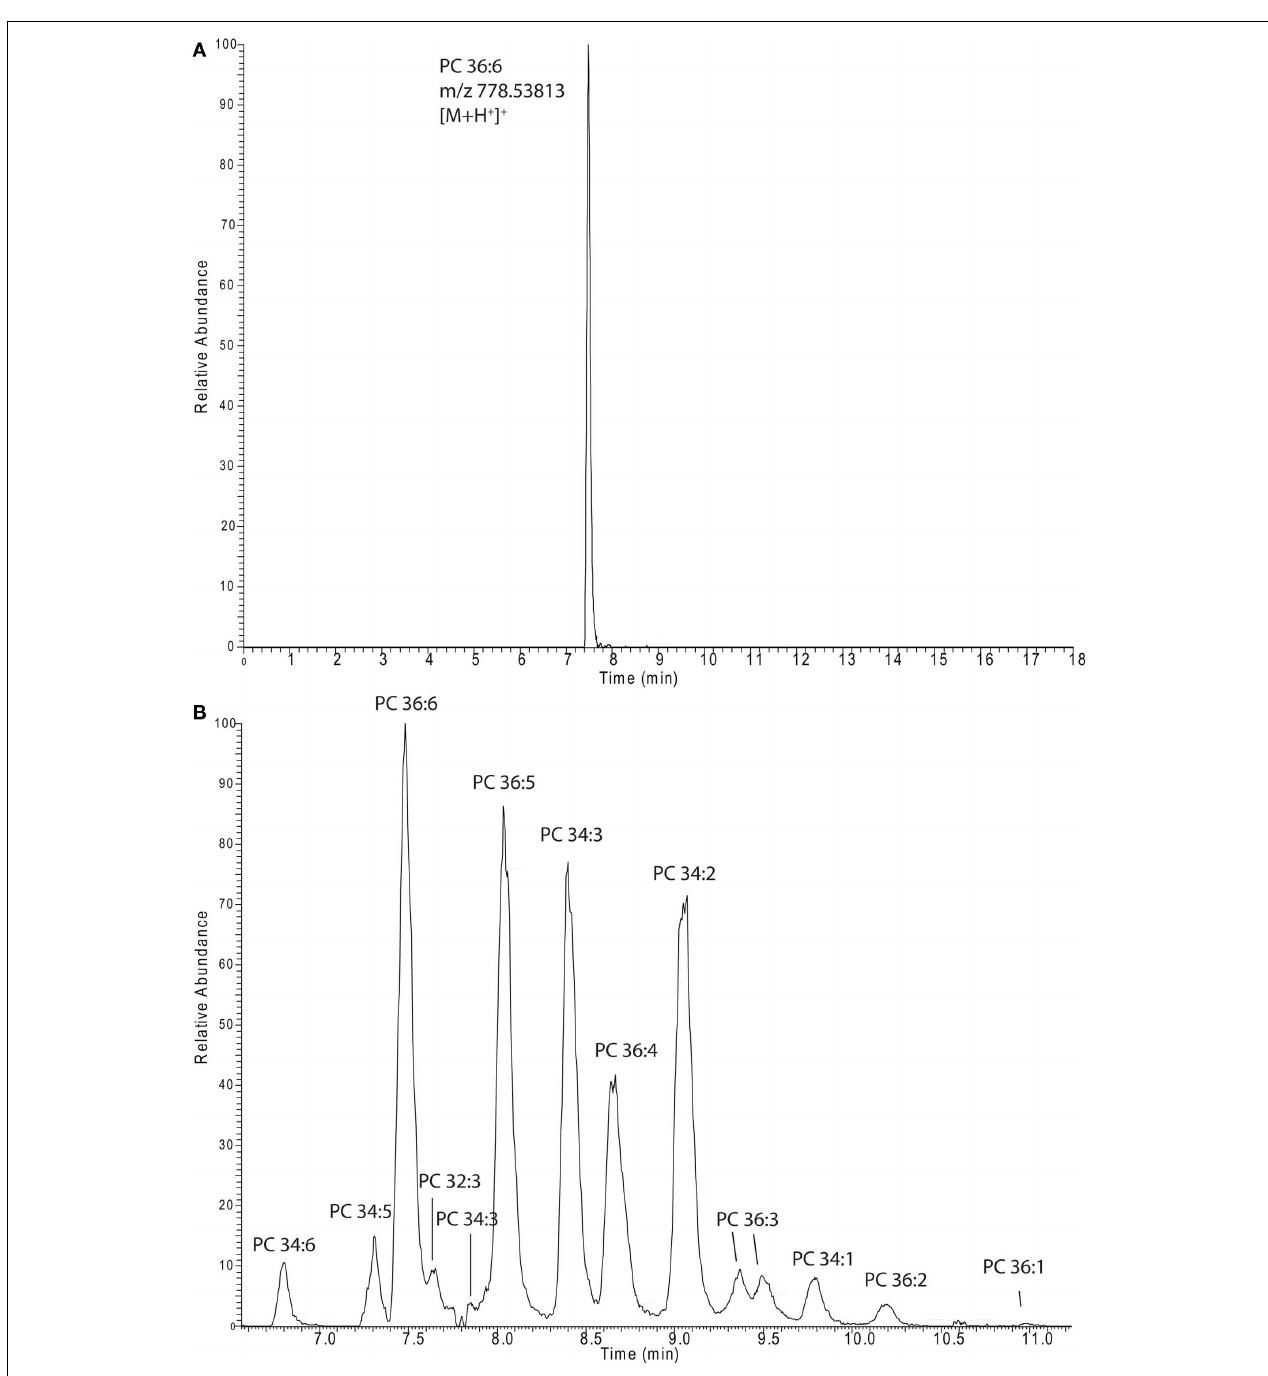
FIGURE 3 | Extracted ion chromatograms of a single lipid species [PC 36:6 (A)] or a whole series of lipids [PCs (B)]. The spectra were recorded in and extracted from positive ion mode lipid chromatograms ( Figure 1A ).